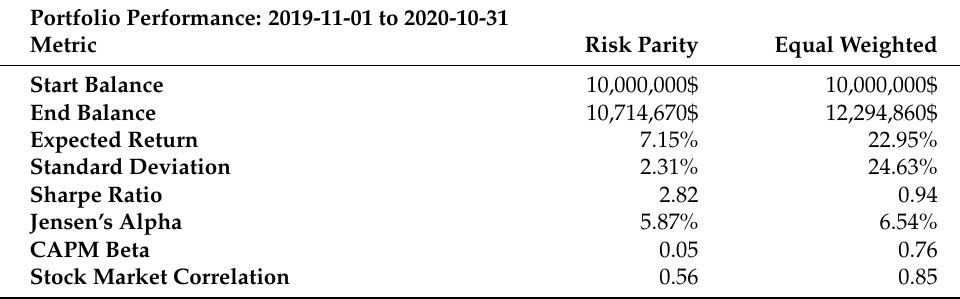
Table 5. Risk parity versus equal weighting during COVID-19 Phase